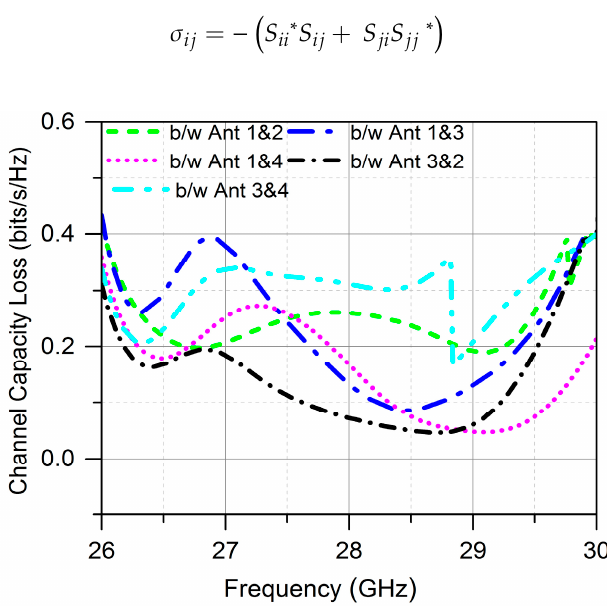
Figure 10. Channel capacity loss analysis of proposed MIMO antenna.